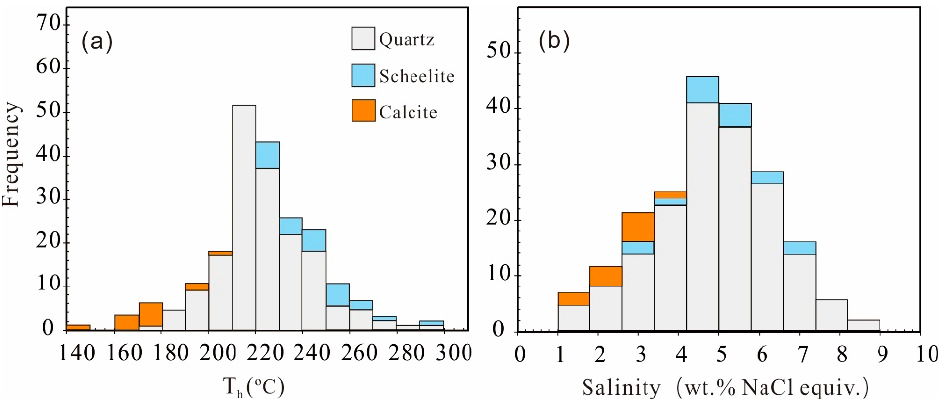
Figure 8. Histograms of ( a ) homogenization temperature and ( b ) salinity of the fluid inclusions in quartz, scheelite, and calcite.